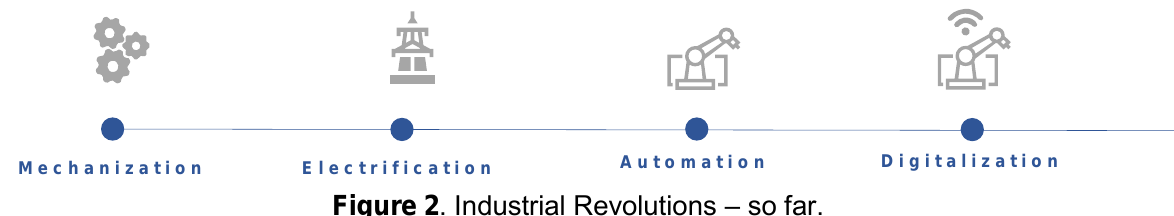
Figure 2 . Industrial Revolutions – so